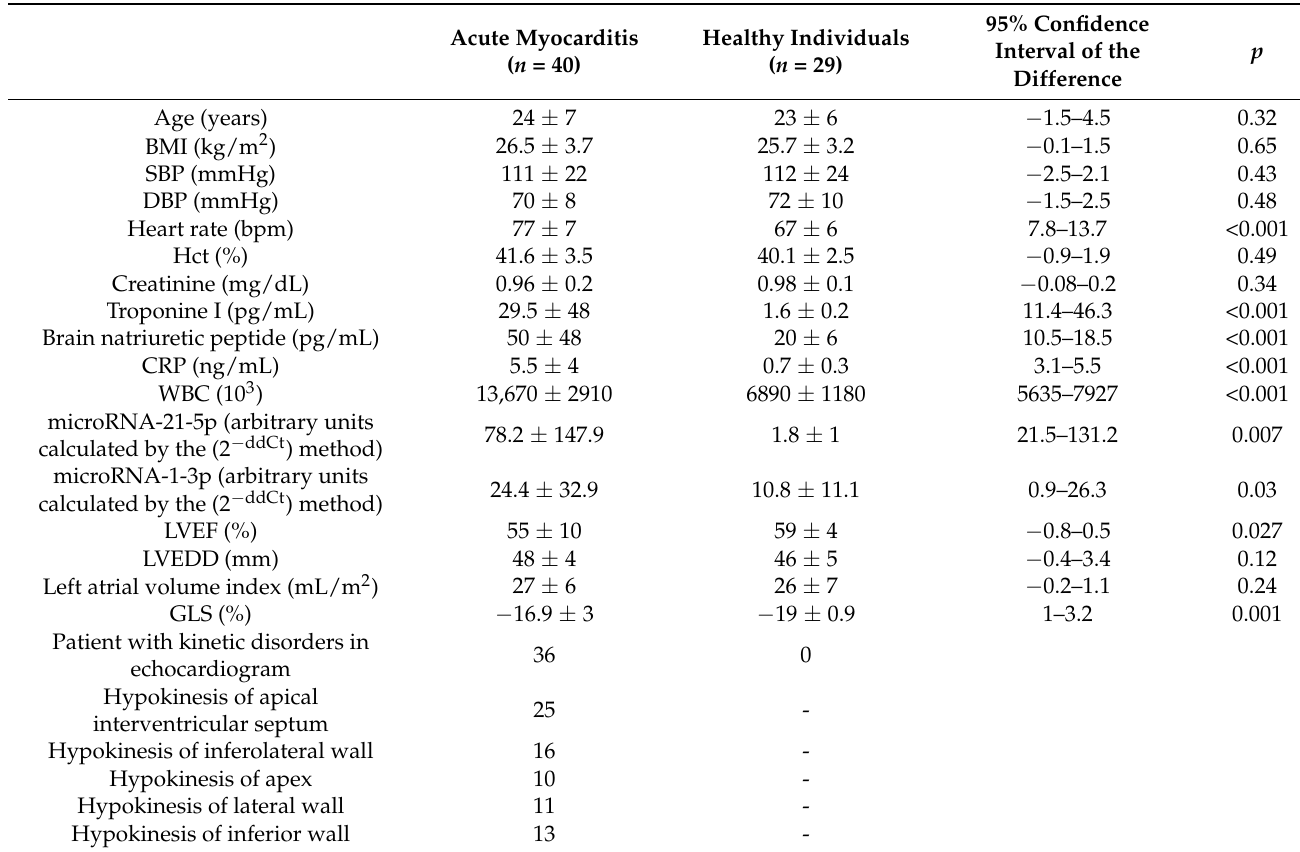
Table 1. Demographic and clinical characteristics of enrolled participants. 95% Confidence Acute Myocarditis Healthy Individuals Interval of ( n = 40) ( n = 29)